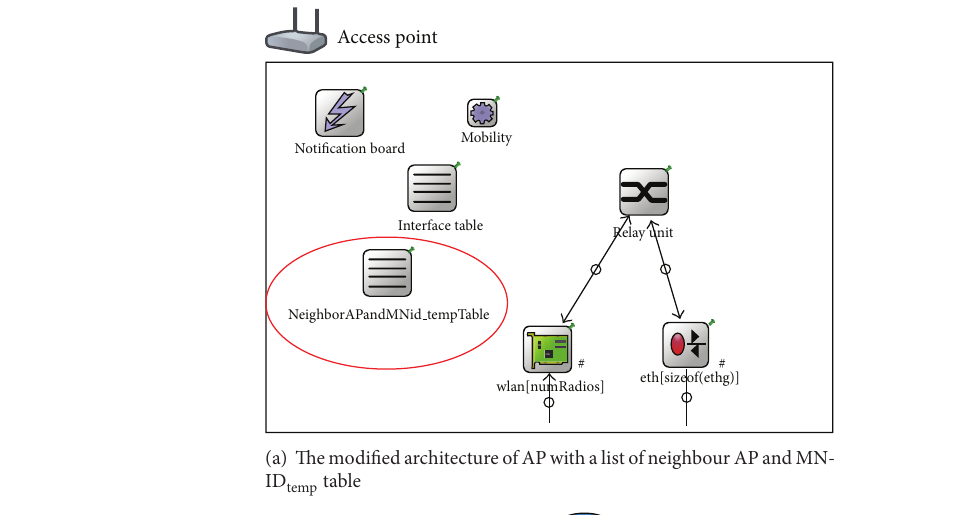
table 6 Network layer